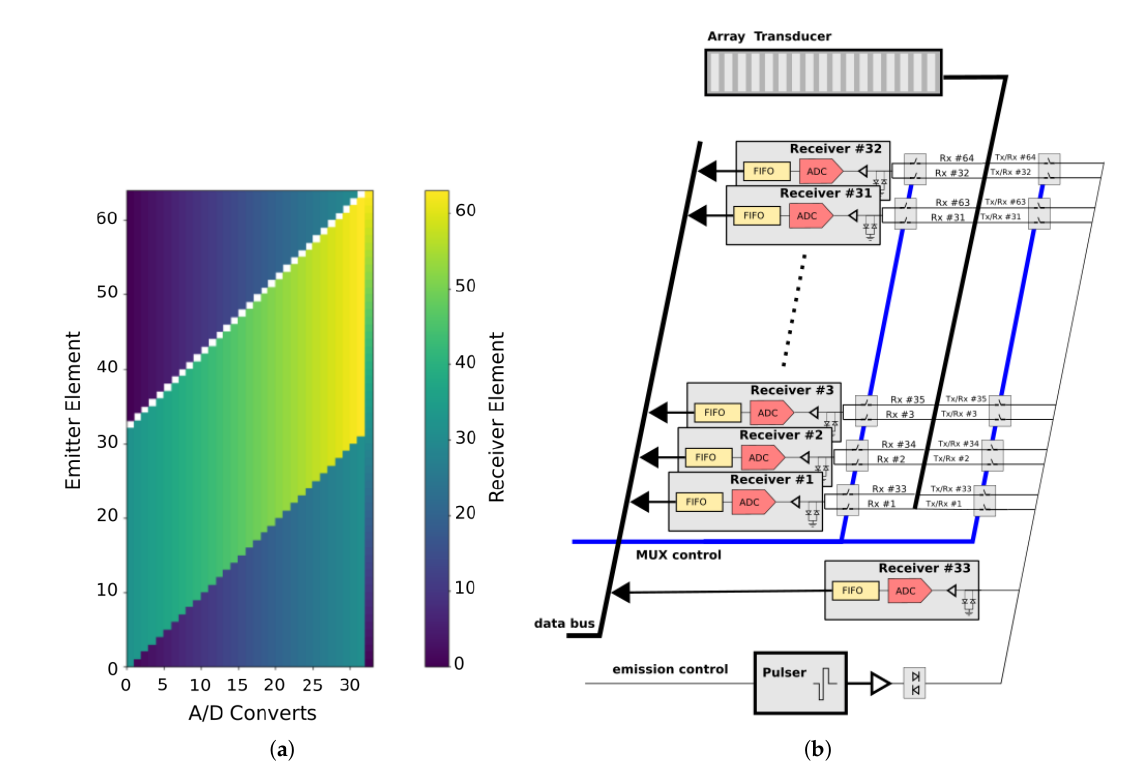
Figure 3. ( a ) Compact representation of ACQ 2 and ( b ) a corresponding ultrasonic acquisition